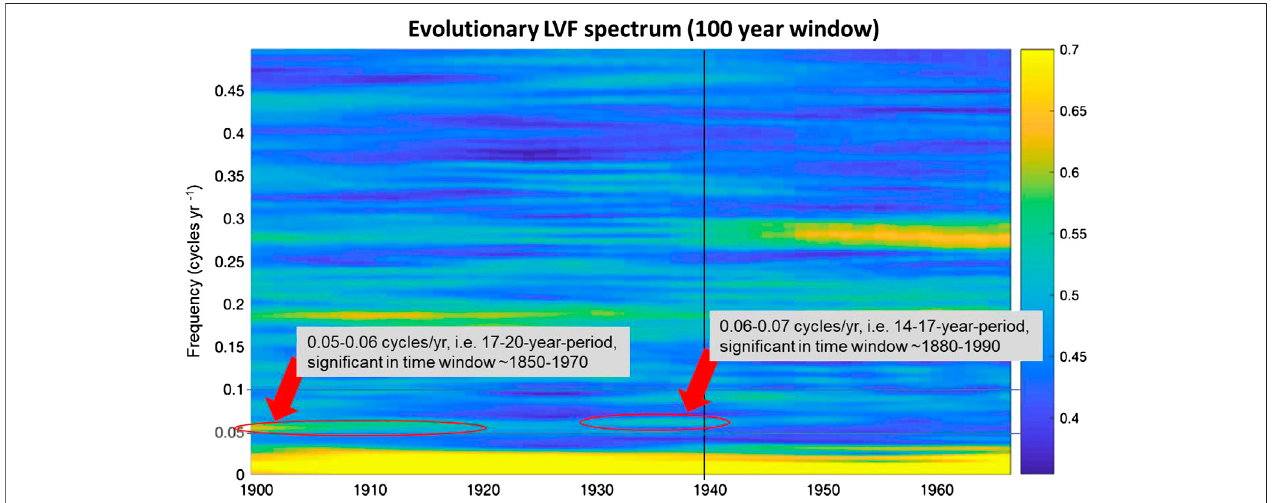
FIGURE1| EvolutionaryspectraofhistoricalobservationsinM20,usingamovingwindowof100 yearslength.Theyearatthehorizontalaxisrepresentsthecenter of the 100 years moving window, with the vertical line indicating the window 1890 – 1990 analyzed by Mann and Park 1994. The colored scale depicts LVF values (In the 100 years time series in Mann and Park, 1994, LFV values exceeding roughly 0.53 were signi fi cant at p < 0.05 level). The red arrows point to two slightly different frequenciesshowingupepisodicallysigni fi cantandtherebysupportingtheviewthatthePDOischaracterizedbyaratherbroadandchangingfrequencybandover time (Figure adapted from Mann et al., 2020, Supplementary Figure 2. Using the fi gure is permitted by the Creative Commons Attribution 4.0 International License).